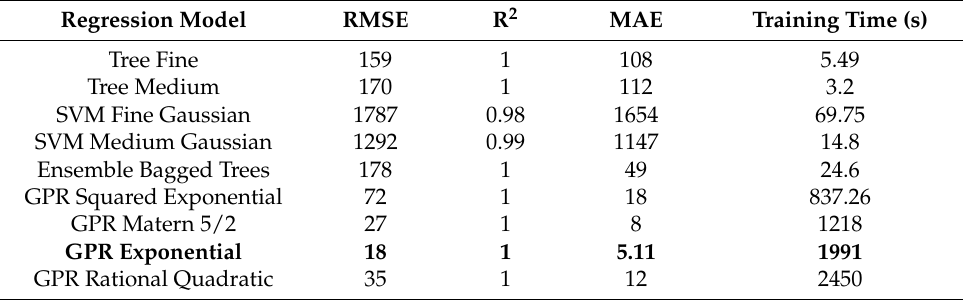
Table 6. Statistical outputs of regression models.